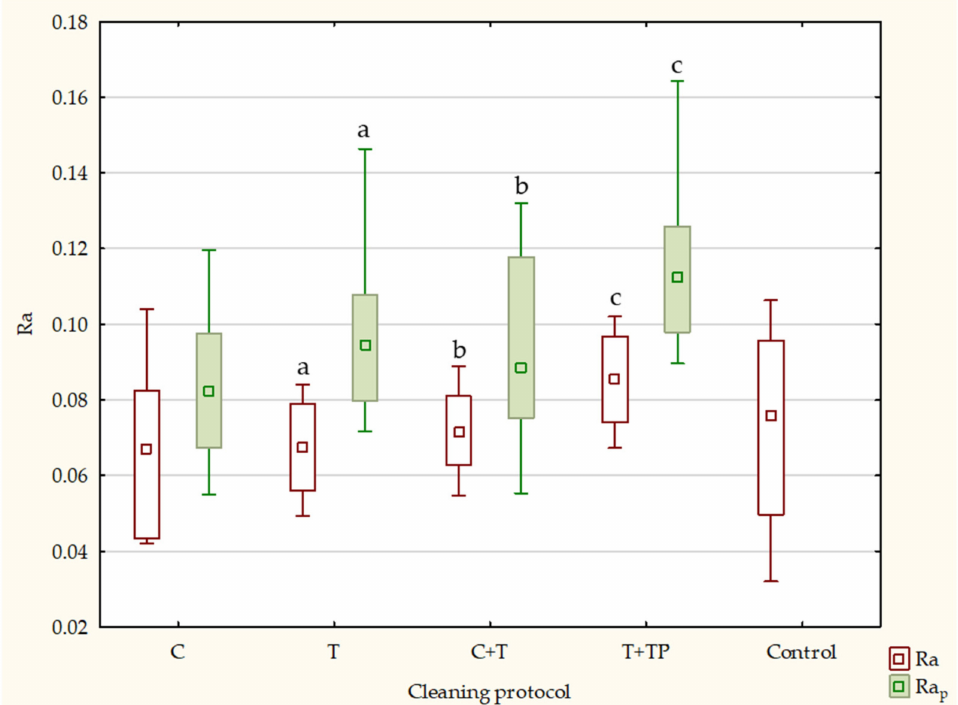
Figure 4. Surface roughness of the Biolon top side in different cleaning protocols; median, box: 25–75%, whisker: non-outlier range; C—Corega, T—toothbrush, TP—toothpaste, Rap—surface roughness after cleaning protocol; a p = 0.011719, b p = 0.011719, c p = 0.011719.